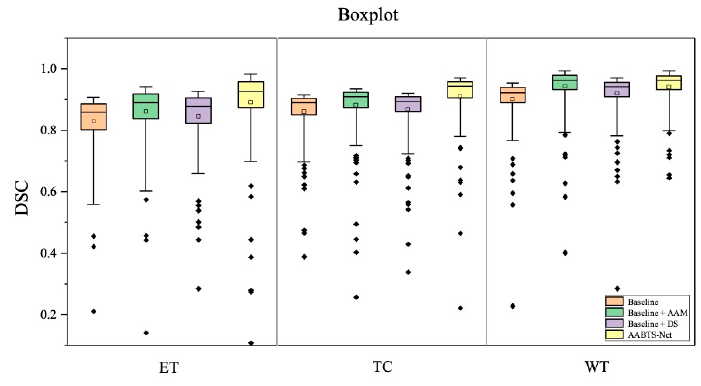
Figure 7. The visualized segmentation results of the proposed AABTS-Net and the AABTS-Net without AAM. ( a , b ) represent the different visualized cases. From left to right: T1, T2, T1c, Flair, Ground truth, the result segmented by AABTS-Net with the AAM and the result segmented by AABTS-Net without the AAM.